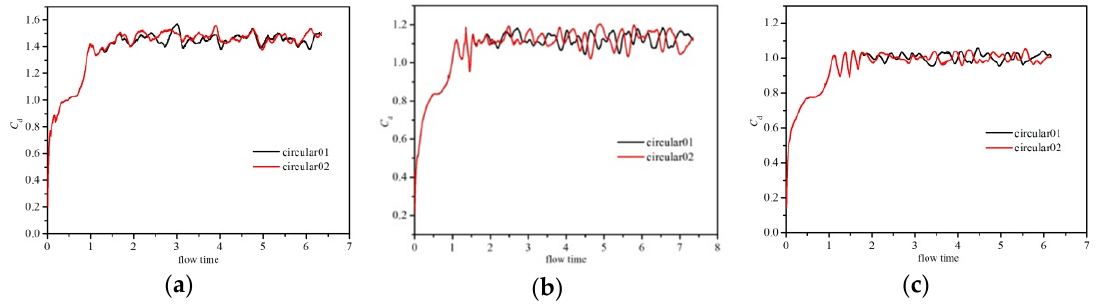
Figure 5. The drag coefficient for G/D = 1.0. ( a ) T/D = 1.25; ( b ) T/D = 1.5; and ( c ) T/D = 1.75.